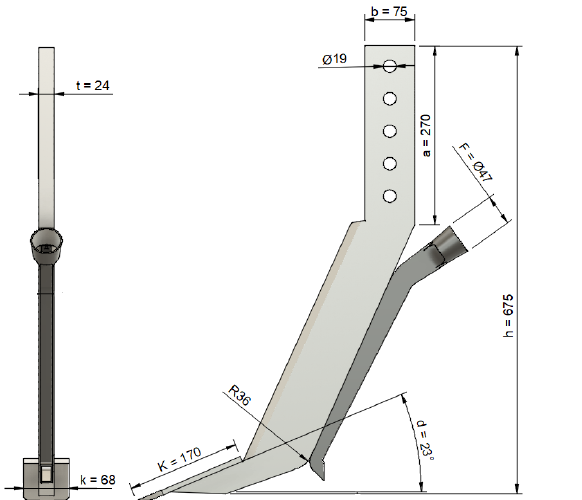
Figure 5: Schematic diagram of the DPFA